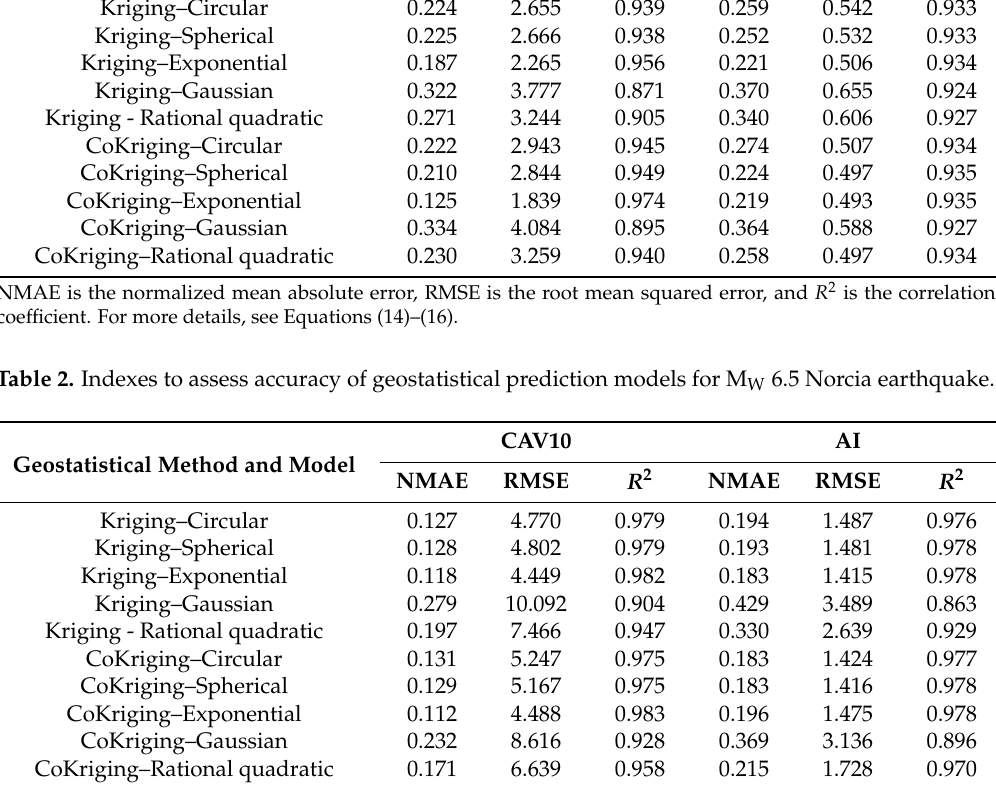
Table 1. Indexes to assess accuracy of geostatistical prediction models for M W 6.0 Amatrice earthquake.